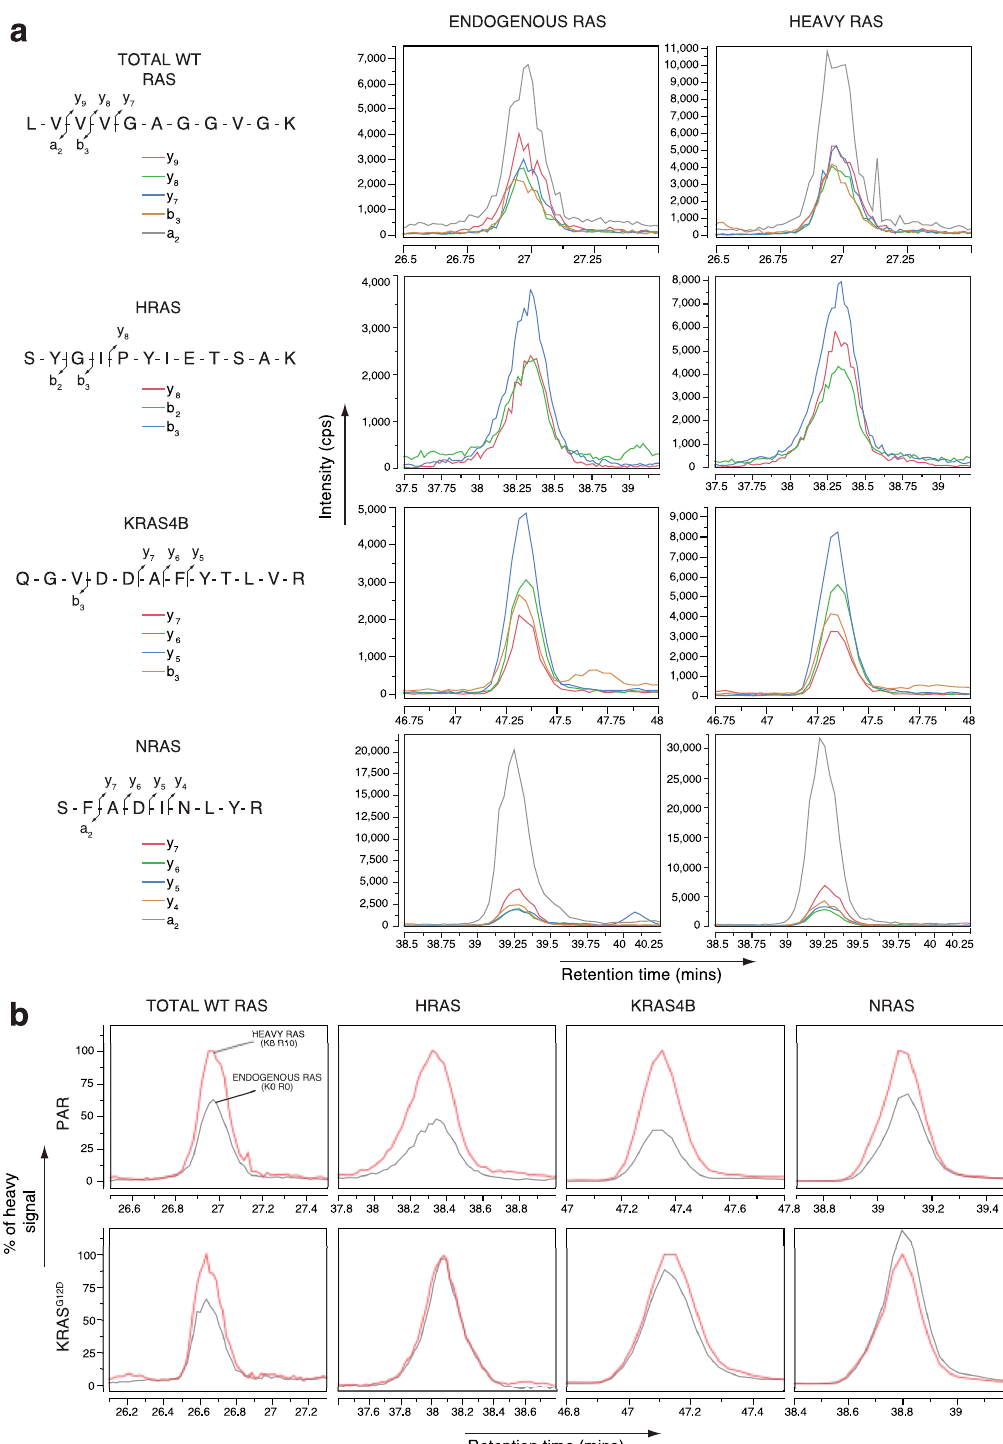
Fig 3. Selected reaction monitoring of proteotypic Ras peptides in SW48 isogenic cell lines. (A) Individual transitions of endogenous (Lys0 Arg0) and heavy (Lys8 Arg10) peptides describing total wild type, HRAS, KRAS4B and NRAS abundance in the Parental (homozygous KRAS WT ) SW48 cell line. (B) Integrated transitions (normalised to heavy signal) of the proteotypic Ras peptides in Parental (PAR) and heterozygous KRAS G12D knock-in (KRAS G12D ) SW48 cells. Presented data representative of 3 biological replicates.